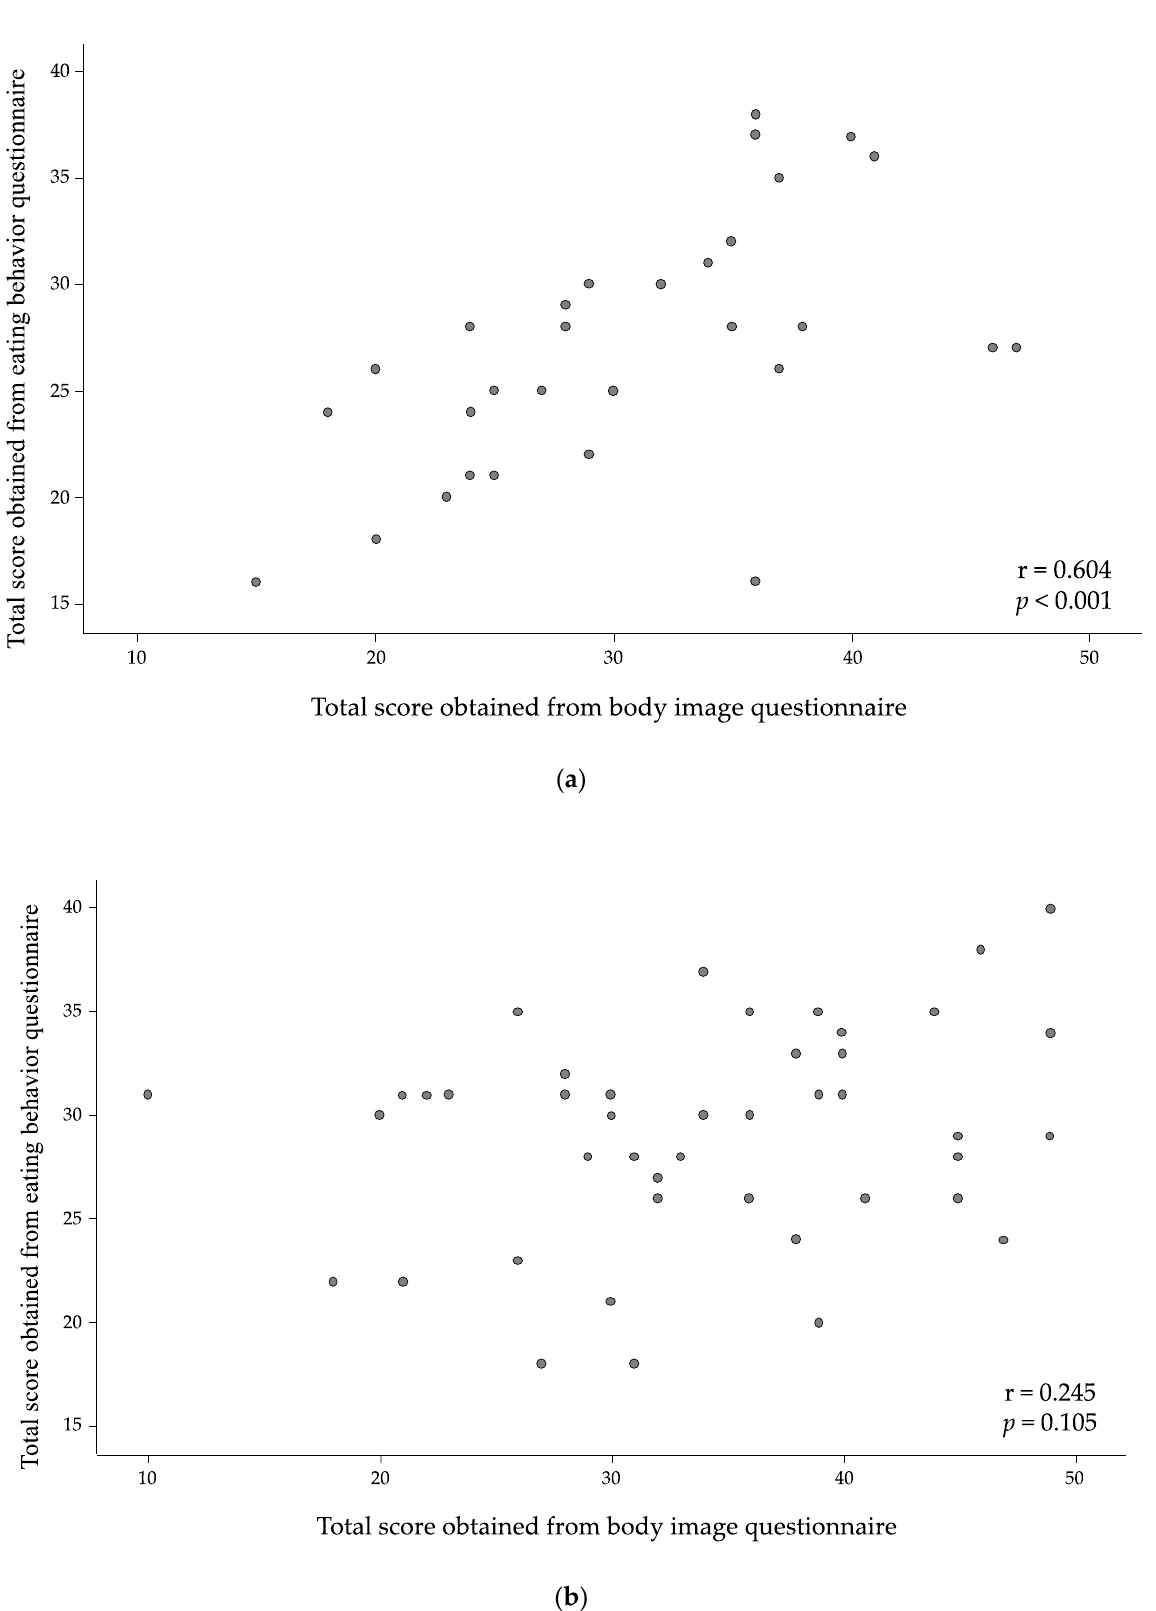
Figure 1. Relationship between body image score and eating behavior score in para-athletes ( a ) and collegiate student athletes ( b ). Total score obtained from body image questionnaire and eating behavior questionnaire showed a significant positive correlation in para-athletes (r = 0.604, p < 0.001).